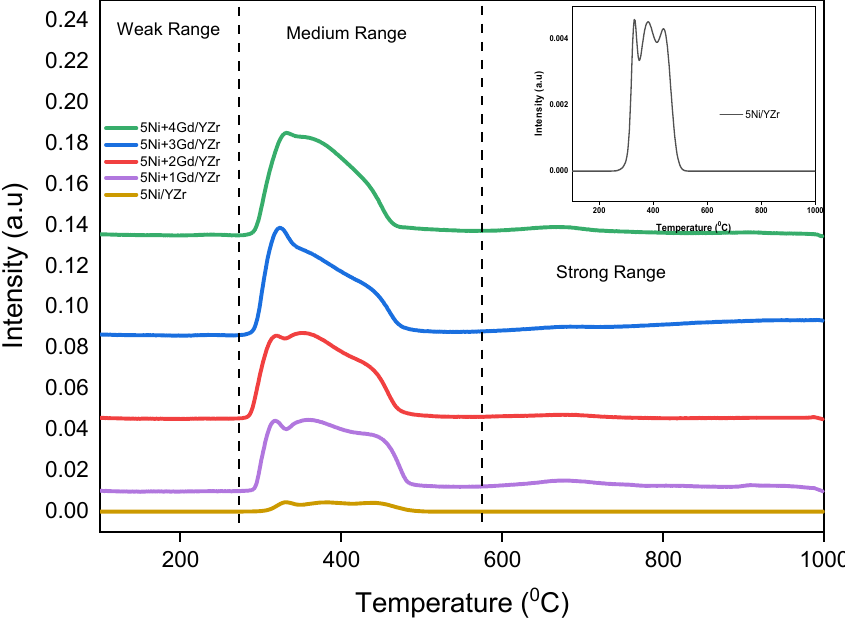
Figure 2. H 2 -TPR profiles of the fresh catalysts (inset of figure: H 2 -TPR of 5Ni/YZr added for clarity because of its very weak TCD intensity).